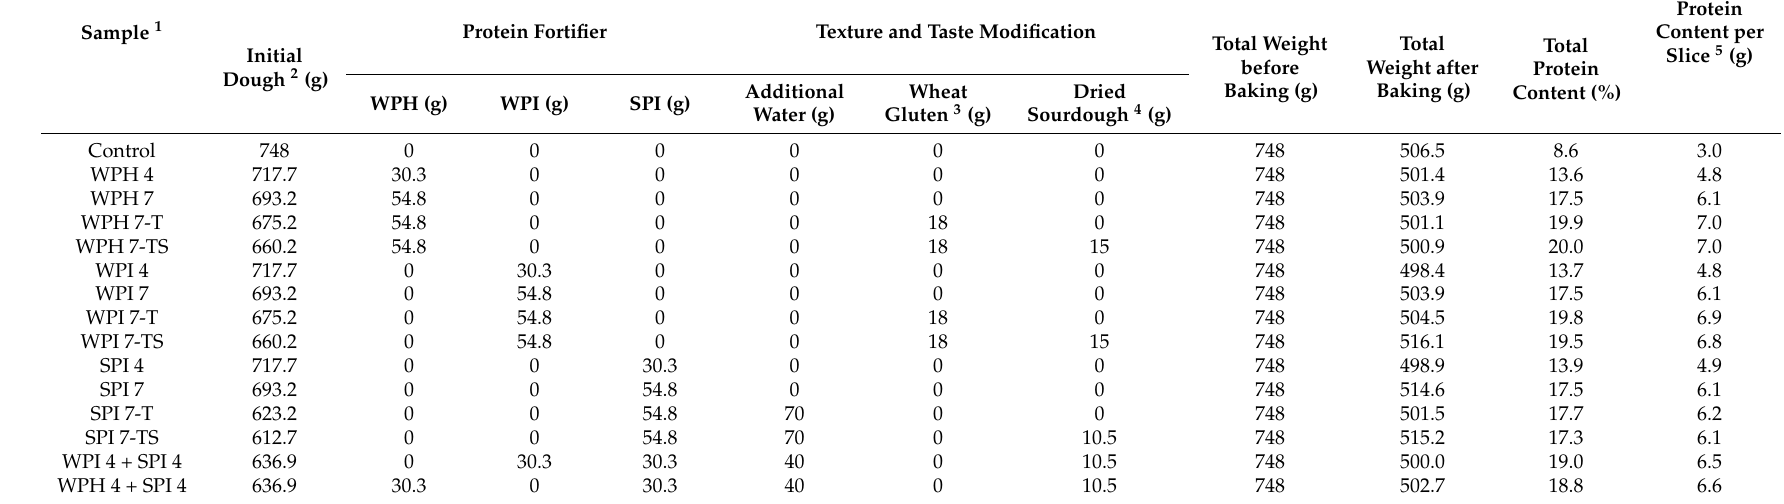
Table 1. Recipes of rye bread samples (per